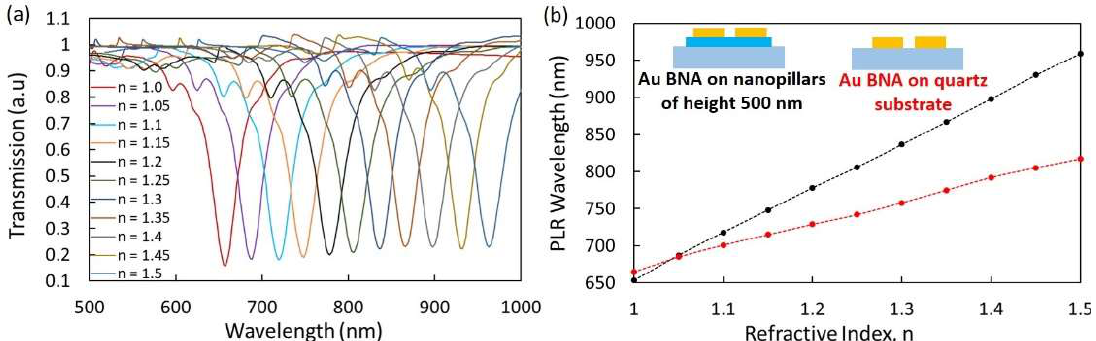
Figure 5. ( a ) The transmission spectra of Au nano antennas on SiO 2 nanopillars placed on the quartz substrate in different ambient media ( b ) Comparison of the sensitivity response for the plasmonic systems with (black dotted line) and without nanopillars (red dotted line).